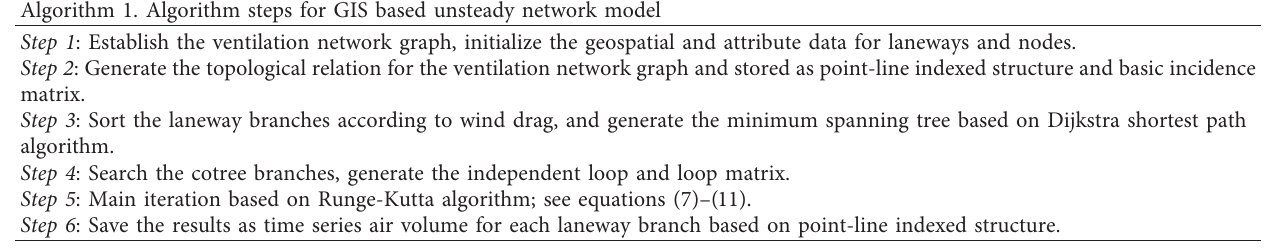
Table 3: The algorithm for GIS Based Unsteady Network Model. Algorithm 1. Algorithm steps for GIS based unsteady network model